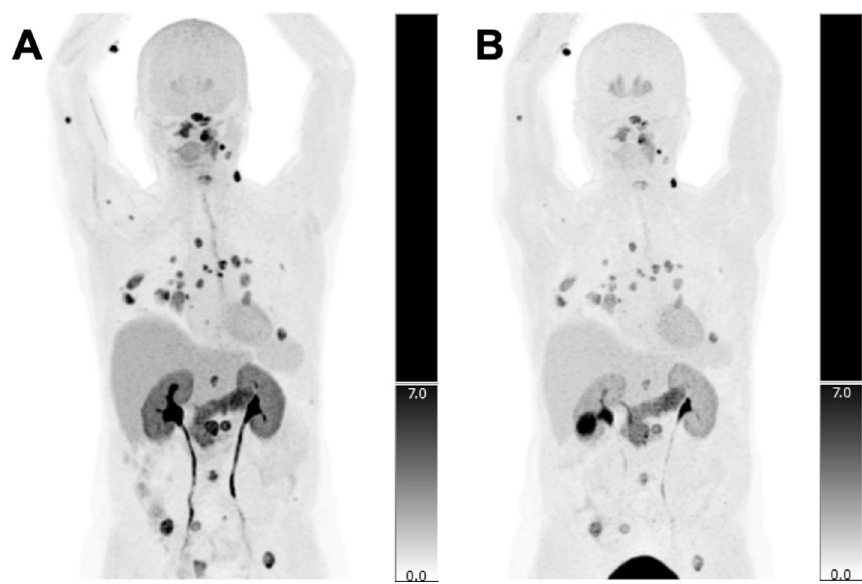
Fig. 4 A 61-year-old woman (patient 1, case 4). A [ 18 F]FDOPA uptake is more intense at the early acquisition 17 min p.i. compared to B the late acquisition at 58 min